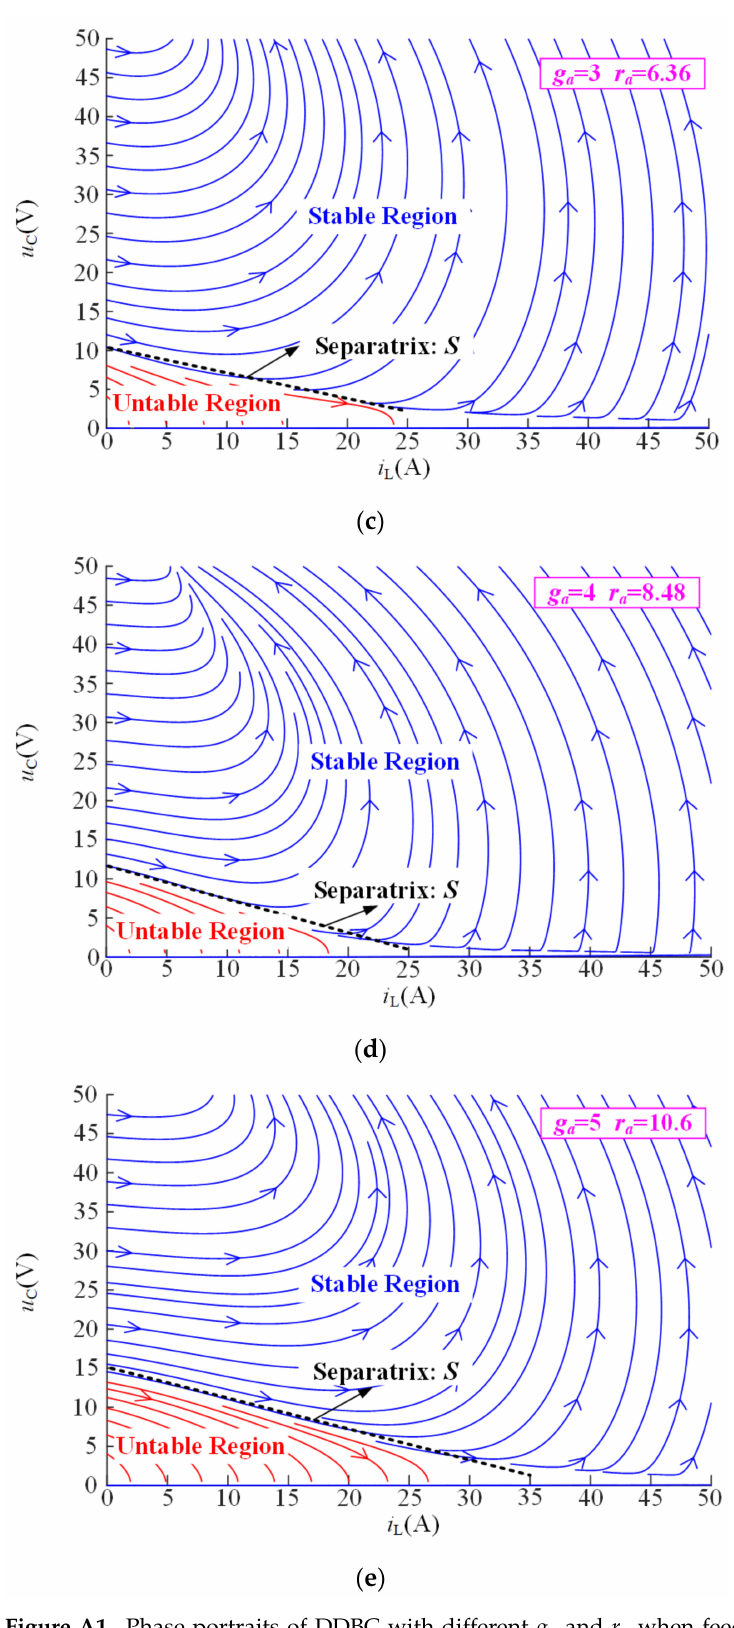
Figure A1. Phase portraits of DDBC with different g a and r a when feeding CPL. ( a ) g a = 1 and r a = 2.12; ( b ) g a = 2 and r a = 4.24; ( c ) g a = 3 and r a = 6.36; ( d ) g a = 4 and r a = 8.48; ( e ) g a = 5 and r a =